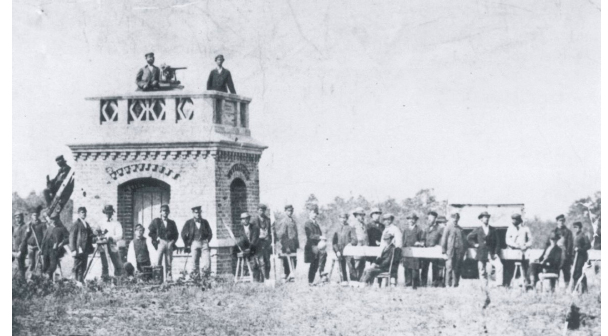
Figure 4. Baseline measurement in Großenhain in 1872, western end point at Raschütz, Nagel (left) and Helmert on the observation building (unknown